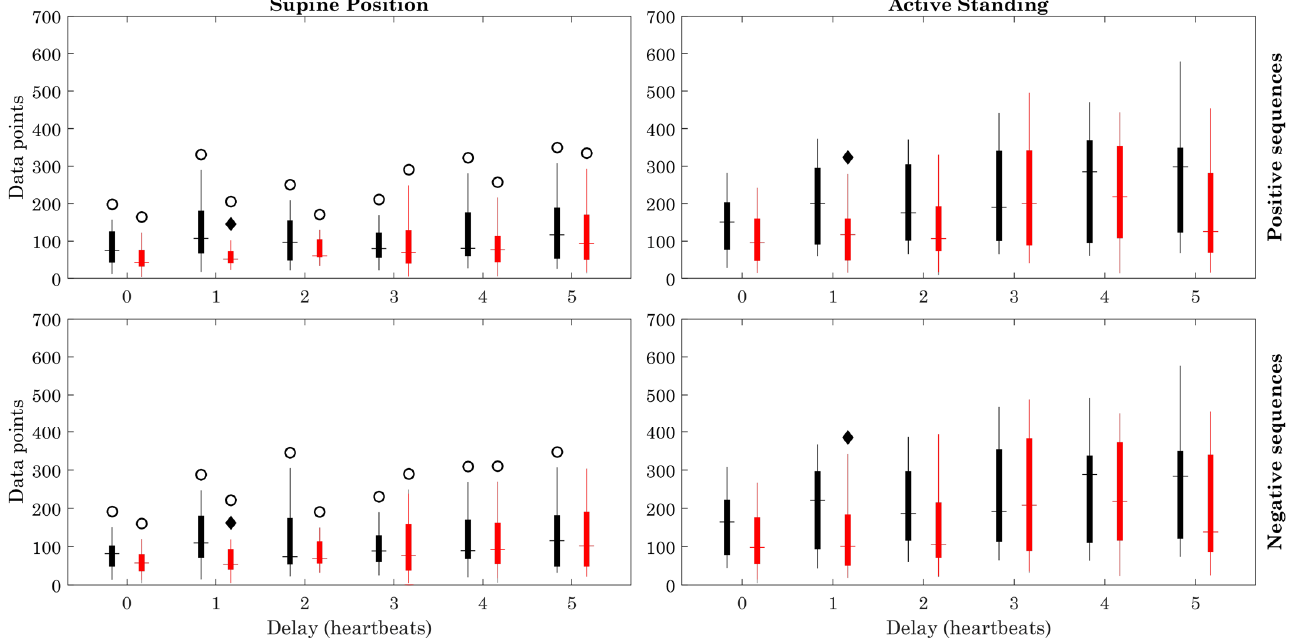
Figure 4. Number of data points. Figure symbology: Healthy subjects (black), ESRD patients (red). Open circle: Supine Position vs. Active Standing (within same group), p < 0.05. Black diamond: ESRD vs. Healthy group (within same position), p < 0.05.